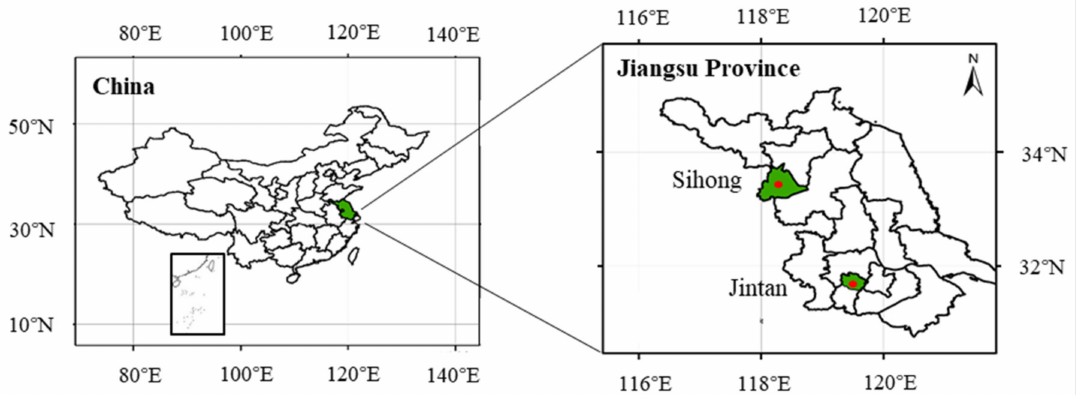
Figure 1. Distribution of test sites in Jiangsu Province, China.